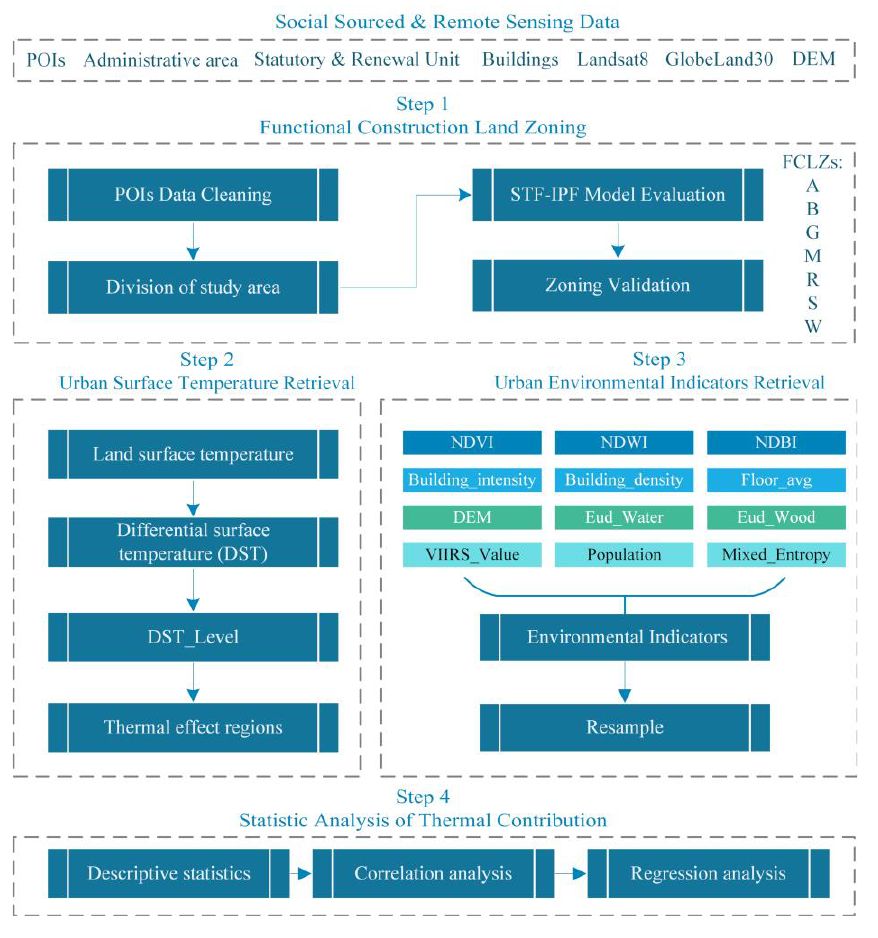
Figure 2. The research framework of heterogeneous thermal contribution analysis in urban construc- tion